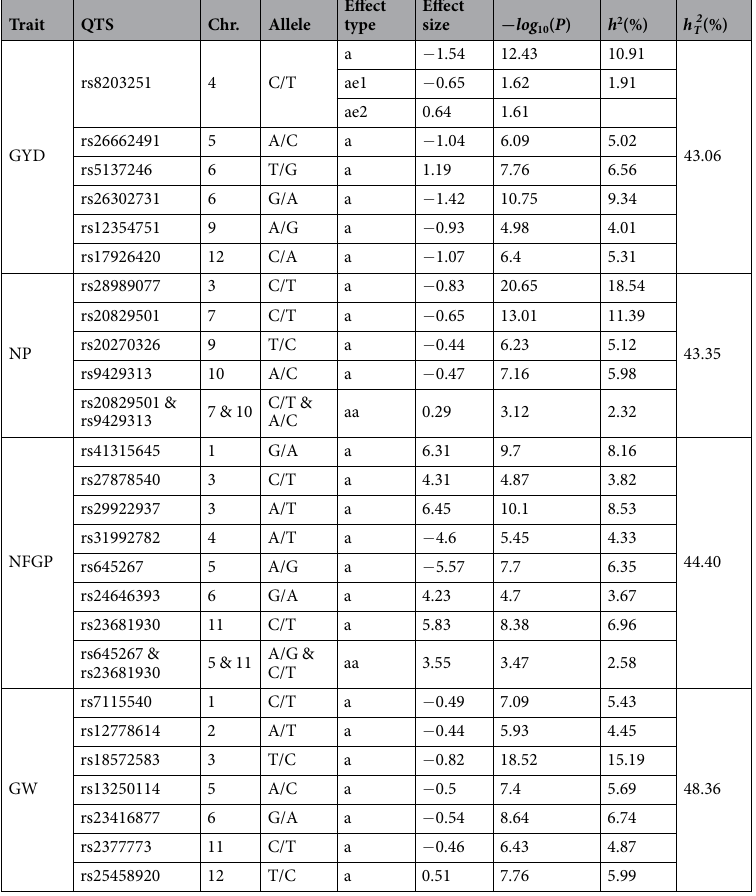
2 (%) = total heritability T